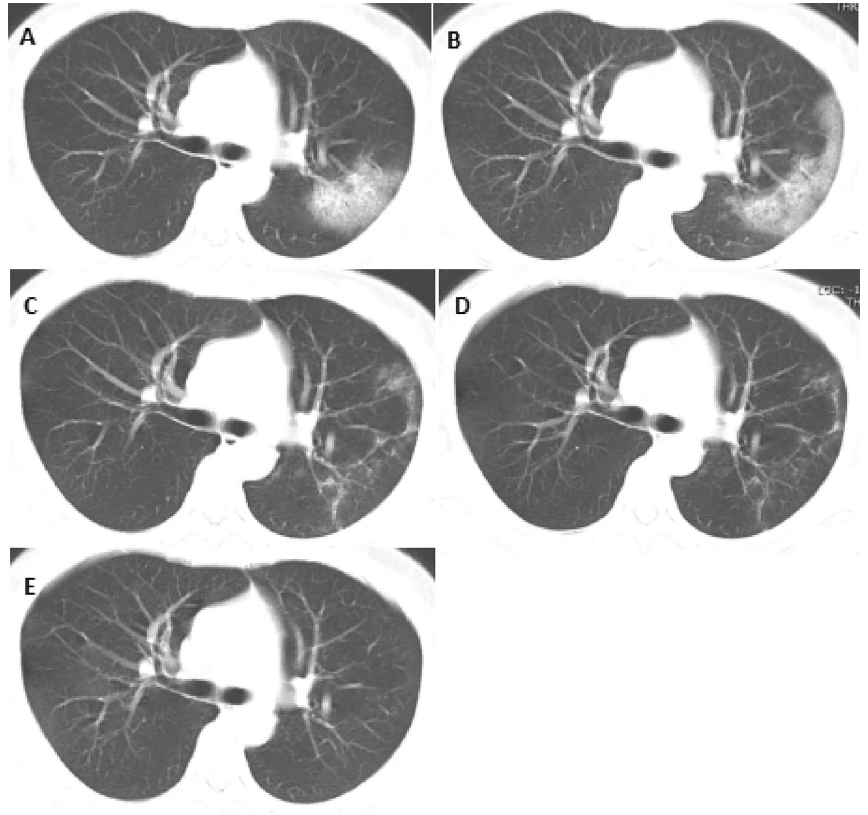
Figure 2. Case of complete absorption of lung lesions. A 44-year-old female patient was hospitalized for 23 days and her lung lesions were gradually absorbed to disappearance. ( A ) The first CT on admission (2020–1– 27): flaky ground glass on the outside of the right lung; ( B ) The second CT (2020–1–31): progression of the right lung lesion, expanded scope; ( C ) Third CT (2020–2–05): obvious absorption of right lung lesions, visible small plate-shaped ground glass opacities and stripe shadows; ( D ) Fourth CT (2020–2–12): the right lung lesions are further absorbed and reduced; ( E ) Fifth CT (2020–2–19): Complete absorption of the right lung lesion. Imaging were acquired on GE AW VolumeShare software (Version number: 4.6; http:// www. gehea lthca re. com/ produ cts/ advan ced- visua lizat ion/ platf orms/ aw-